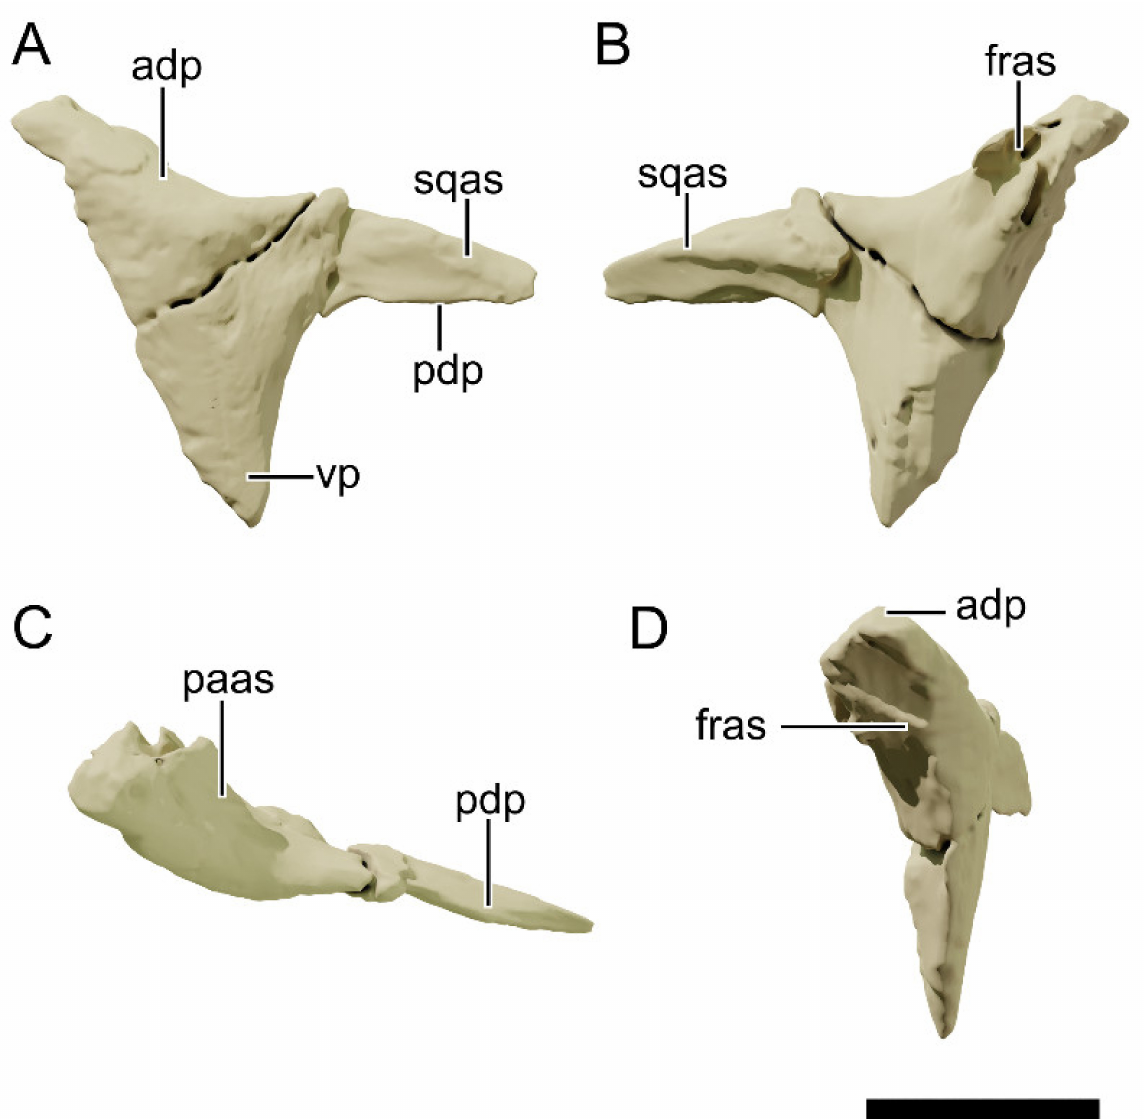
Figure 14. Digital reconstruction of the left postorbital of NHMD 164741. ( A ) Lateral view. ( B ) Medial view. ( C ) Dorsal view. ( D ) Anterior view. Abbreviations: adp, anterodorsal process; fras, articular surface for the frontal; paas, articular surface for the parietal; pdq, posterodorsal process; sqas, articular surface for the squamosal; vp, ventral process. Scale bar = 20